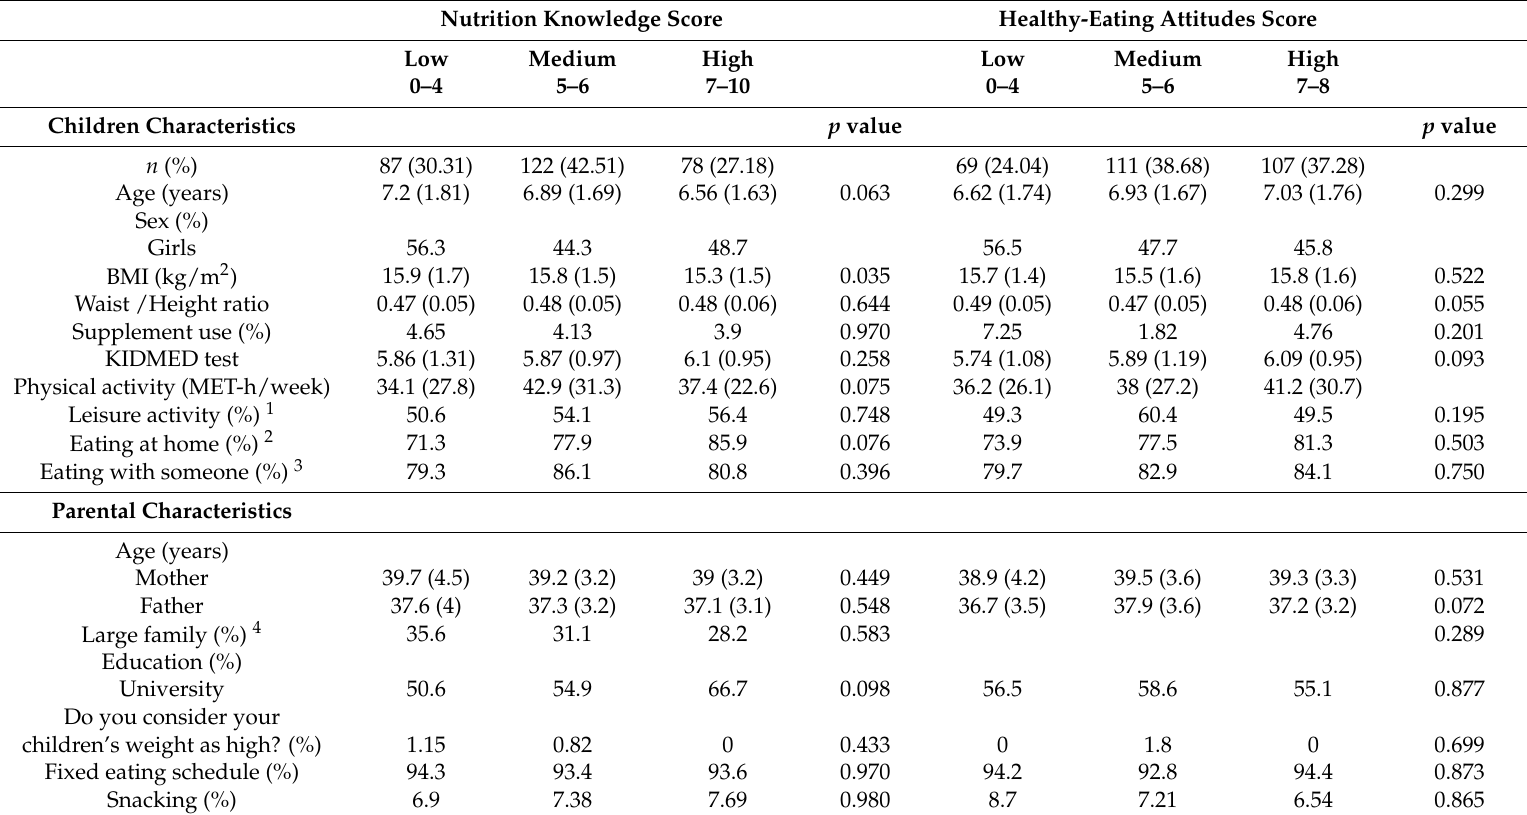
Table 1. Baseline main characteristics of the 287 participants of the SENDO project according to nutrition knowledge and healthy-eating attitudes score (Mean values and standard deviations or number of participants and